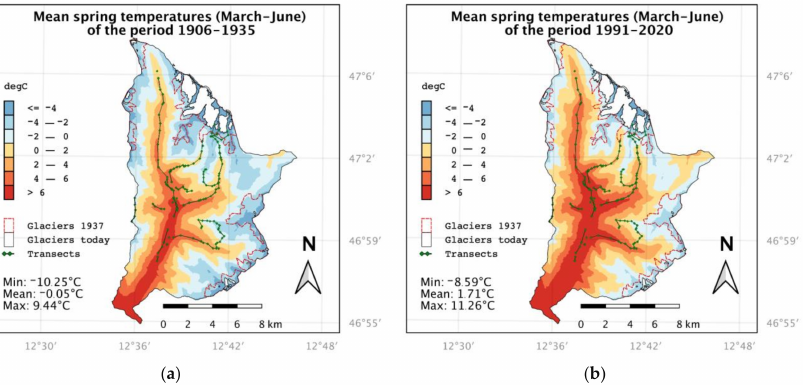
Figure 3. Mean spring temperatures (March–June) of the periods 1906–1935 ( a ) and 1991–2020 ( b ) in Kals am Großglockner. Historic (red—[44]) and recent (white—[50]) glacier cover as well as transects of 2020 (green) are shown on the map. In the lower left, the minimum, mean, and maximum spring temperatures of the study area are